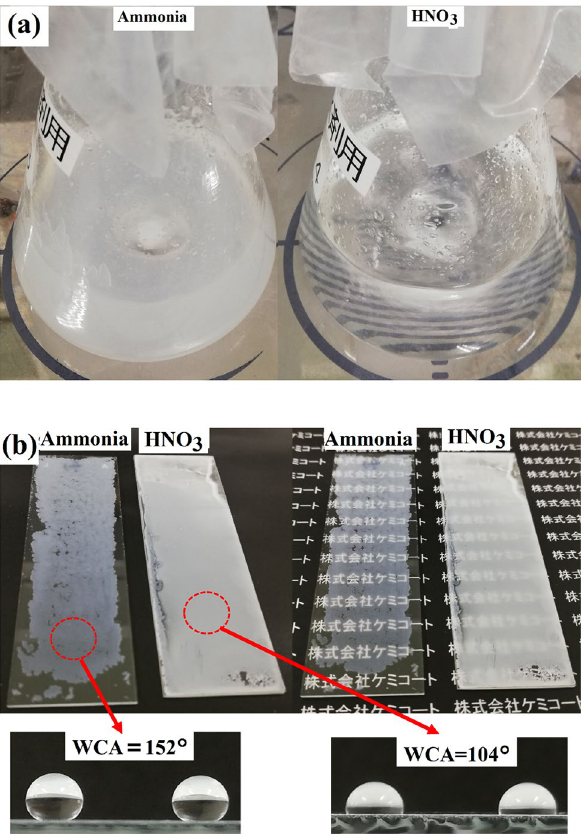
Fig. 5 a Optical photographs and b UV–vis transmittance of the coatings sprayed from the coating solution prepared with the com- position No. 5 by the processing method III on the glass slides with different numbers of sprays. Insets in ( a ): Optical photographs of a 10 μL-water droplet and